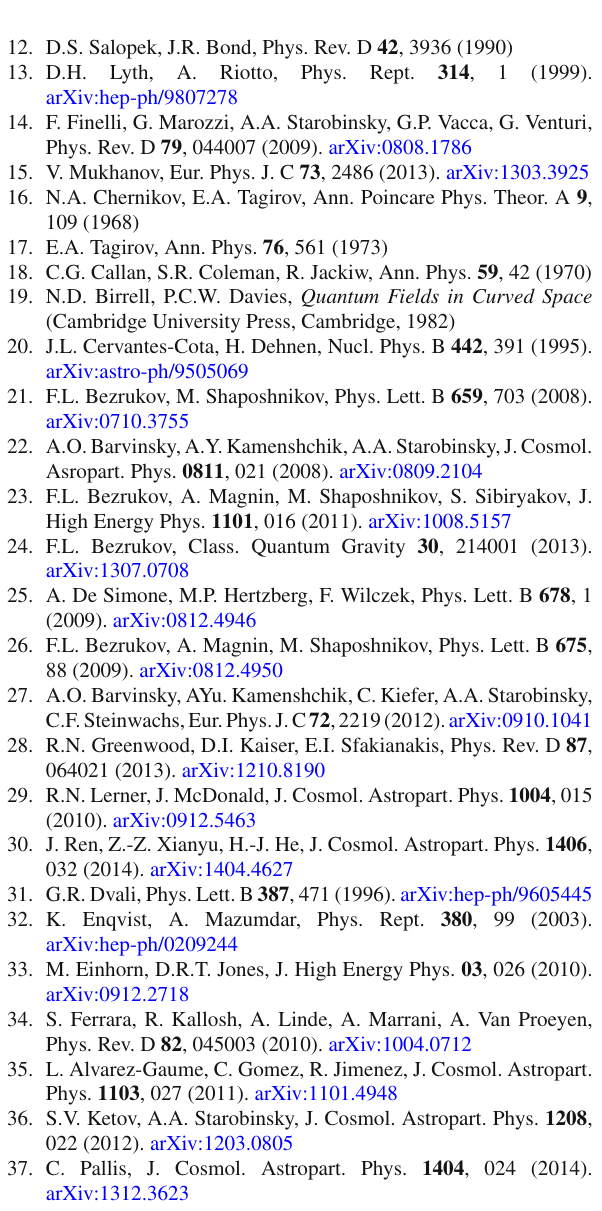
Table 3 Model parameters and the corresponding values of r for the function F with a constant term in the case of K = K u